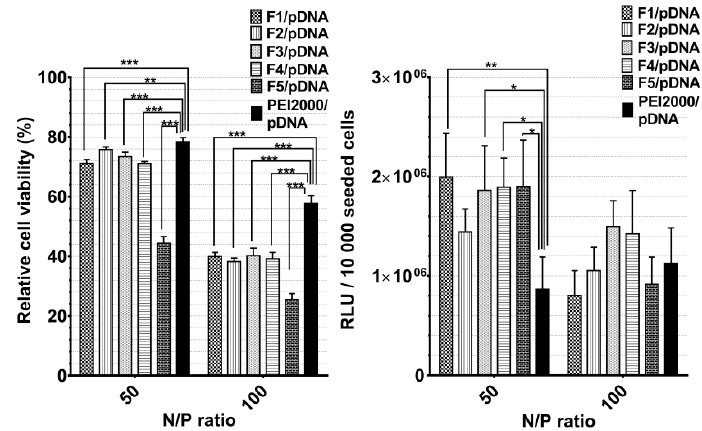
Figure 6. Graphical representation of relative viability and transfection efficiency (relative light units (RLUs) / 10,000 seeded cells.) of Hela cells treated with polyplexes at 50 and 100 N / P ratios. The results are presented as a mean value ± the standard deviation (S.D.); n = 5–7. * p < 0.05, ** p < 0.01, and *** p < 0.001 by Student’s t -test.